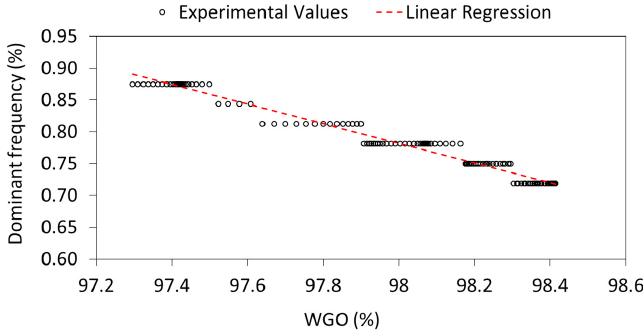
Figure 15. Overload vortex rope frequency for different openings of the wicket gates.